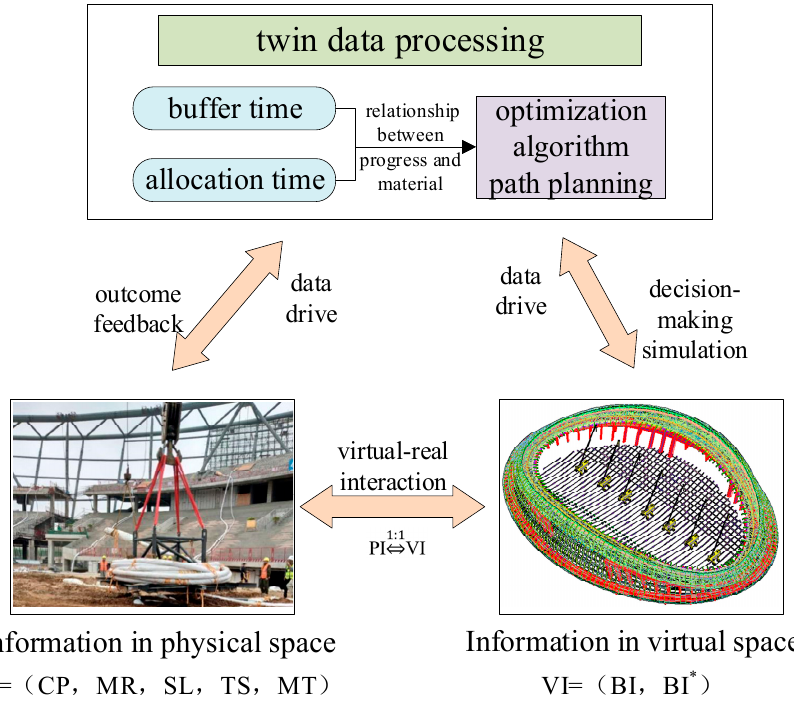
Figure 4. Virtual–real interaction mechanism.